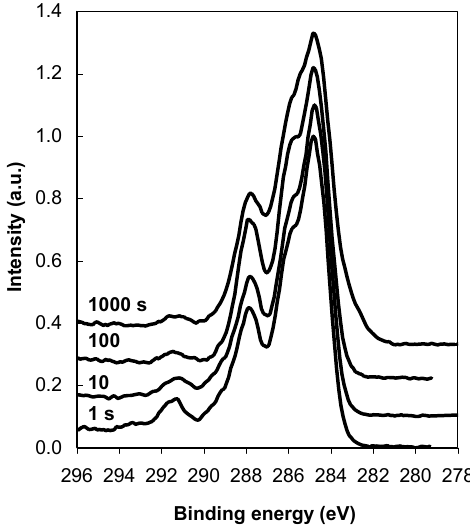
Figure 5. XPS high-resolution spectra of carbon C1s for the CF sample after incubation in an albumin solution for various